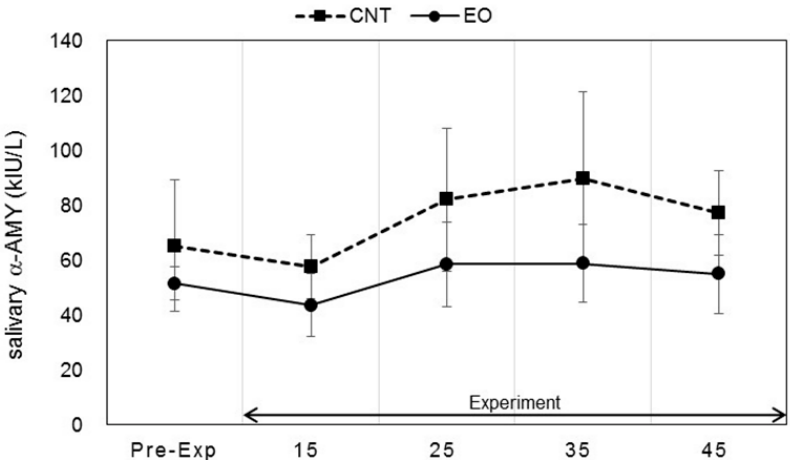
Figure 7. Variation of salivary α -amylase levels at pre- and during-experiment measurements. The plot in Figure 7 describes changes in the salivary α -amylase levels of participants in the control (square) and Japanese cedar wood essential oil (experimental; circle) conditions. CNT indicates the control condition, while EO indicates the experimental condition. Differences between conditions were not significant. Data are shown as mean ± SEM.